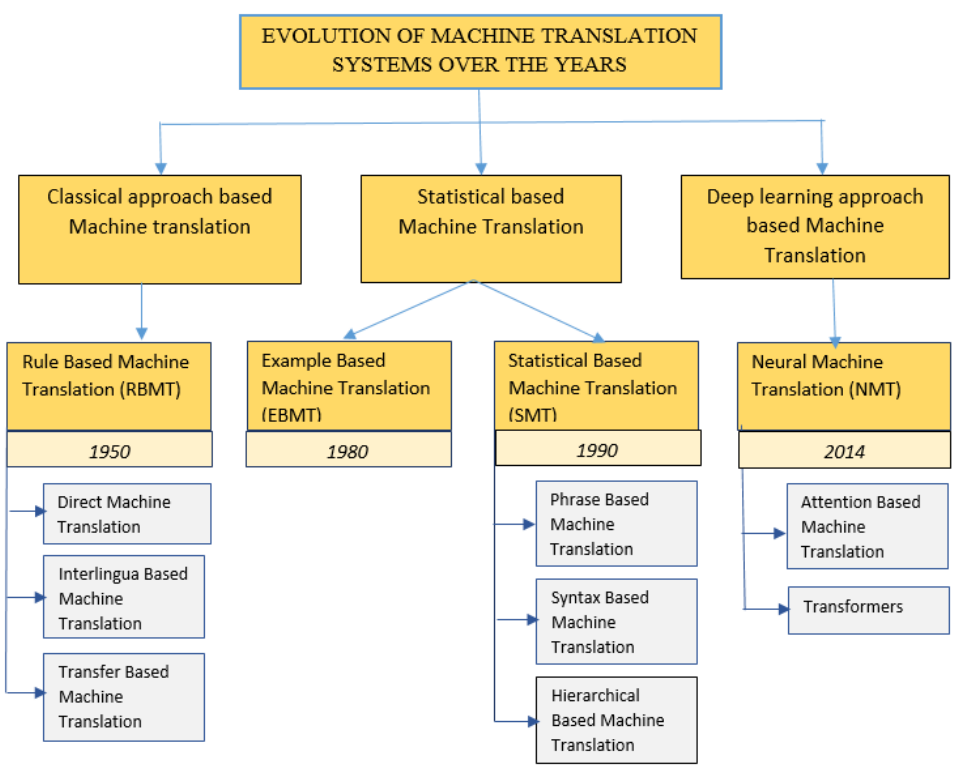
Figure 2. The taxonomy is a representation of the evolving machine translation systems over the